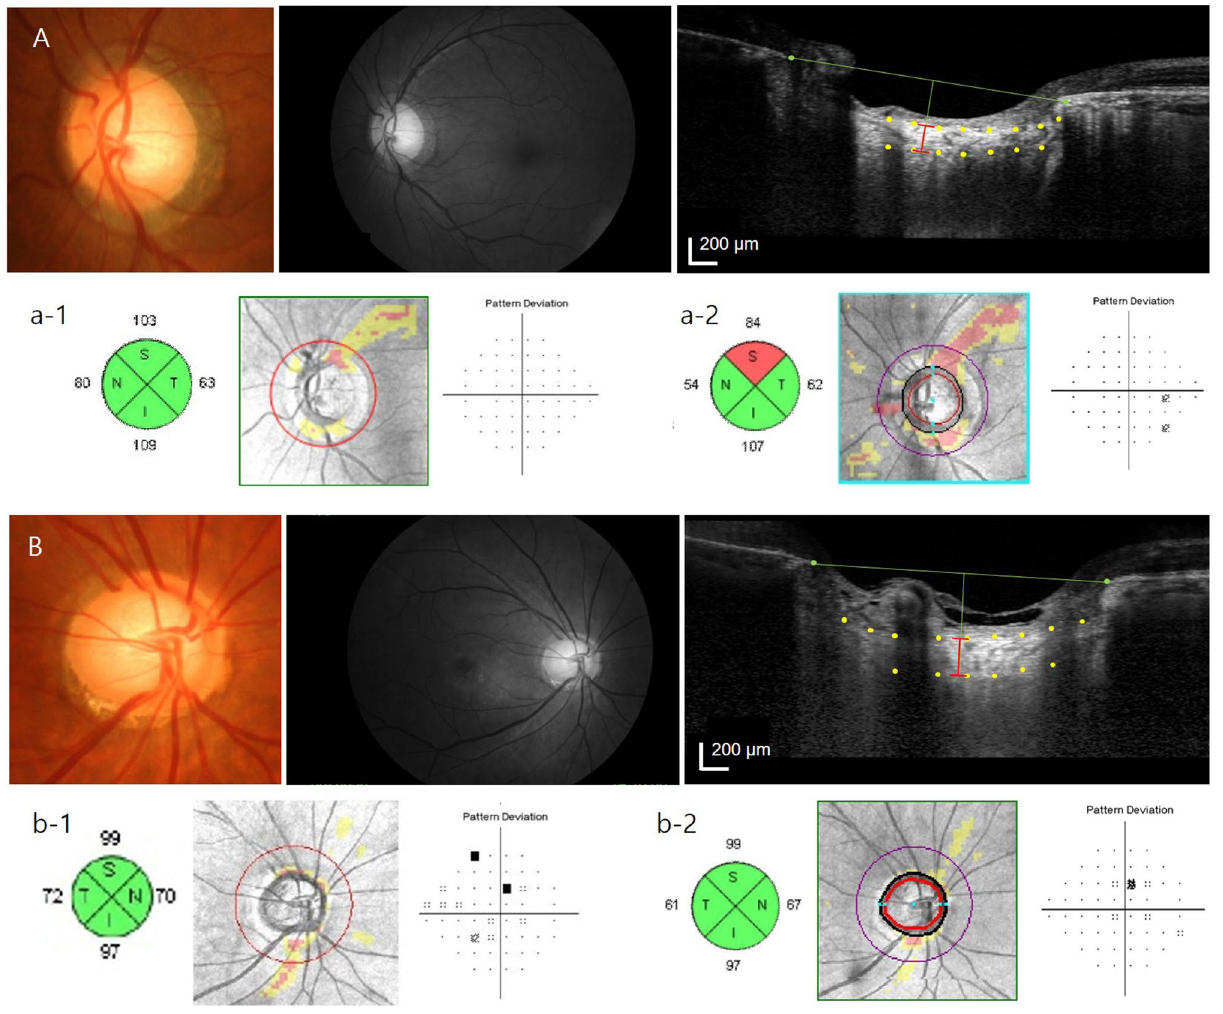
Figure 2. Representative cases showing the degree of disc torsion contributes to normal-tension glaucoma (NTG) conversion in NTG suspects with myopia. ( A ) , A 32-year-old female with large cup-to-disc ratio in the left eye who had been follow-up for 9 years. Fundus photography shows disc torsion to the inferotemporal region for about -7.42° ( a-1 ). Optic nerve head scan shows laminar cribrosa thickness of 221 μm ( a- 2 ). Progression to NTG was detected by the presence of localized retinal nerve fiber layer defect at the inferotemporal region ( a-4 ) compared to baseline (a-3). ( B) , A 42-year-old male with large cup-to-disc ratio in the left eye who had been follow-up for 9 years. Fundus photography shows no disc torsion ( b-1 ). Optic nerve head scan shows laminar cribrosa thickness of 216 μm ( b-2 ). Progression to NTG was not detected during the follow-up period ( b-3 and b-4